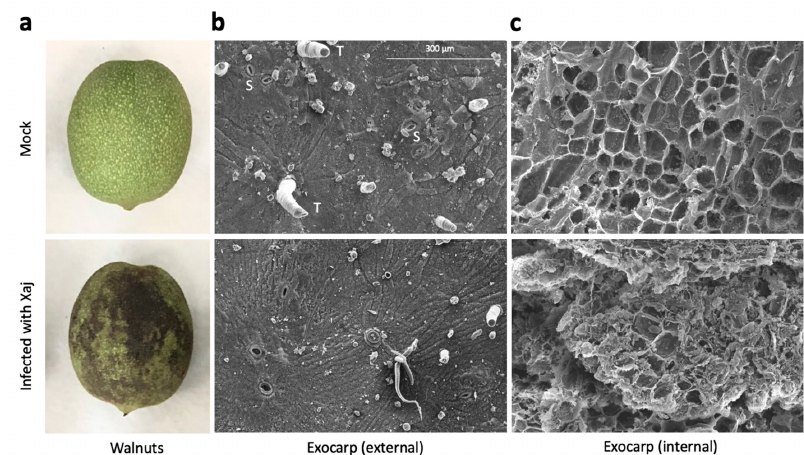
Figure 1. Walnut blight symptoms in walnut fruits. Samples were inoculated with 1 × 10 8 bacterial cells/mL in a solution of MgCl 2 and incubated in a box to maintain high humidity at room temperature for ten days under a 12-hour light/dark cycle. ( a ) Walnut hull symptom development after seven days. ( b ) Scanning electron micrograph of the external and ( c ) internal-facing exocarp tissues (250×) after ten days. S: stomata and T: trichome.